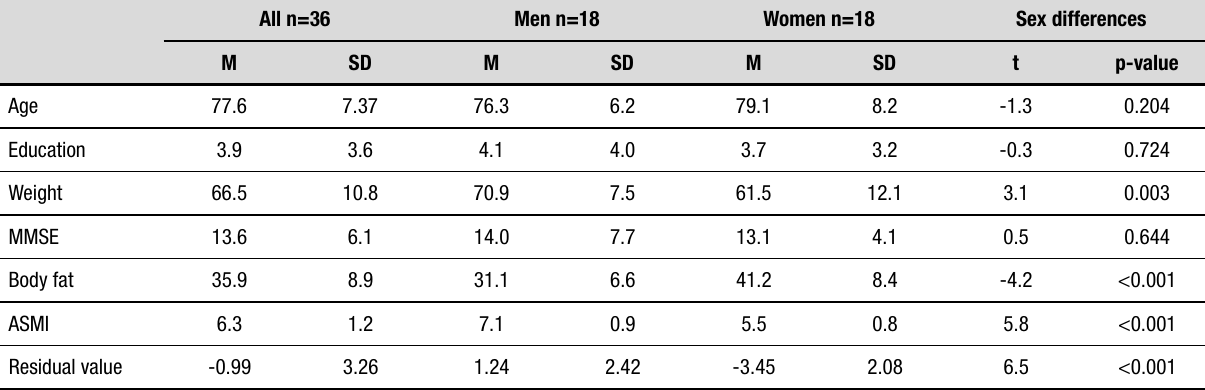
Table 1. Body composition and Mini-Mental State Examination